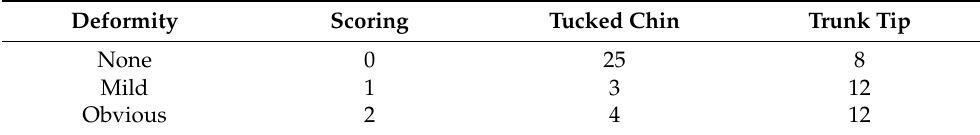
Table 1. Results of screening most recent lateral radiographs for evidence of clinically recognized deformities (N = 32).